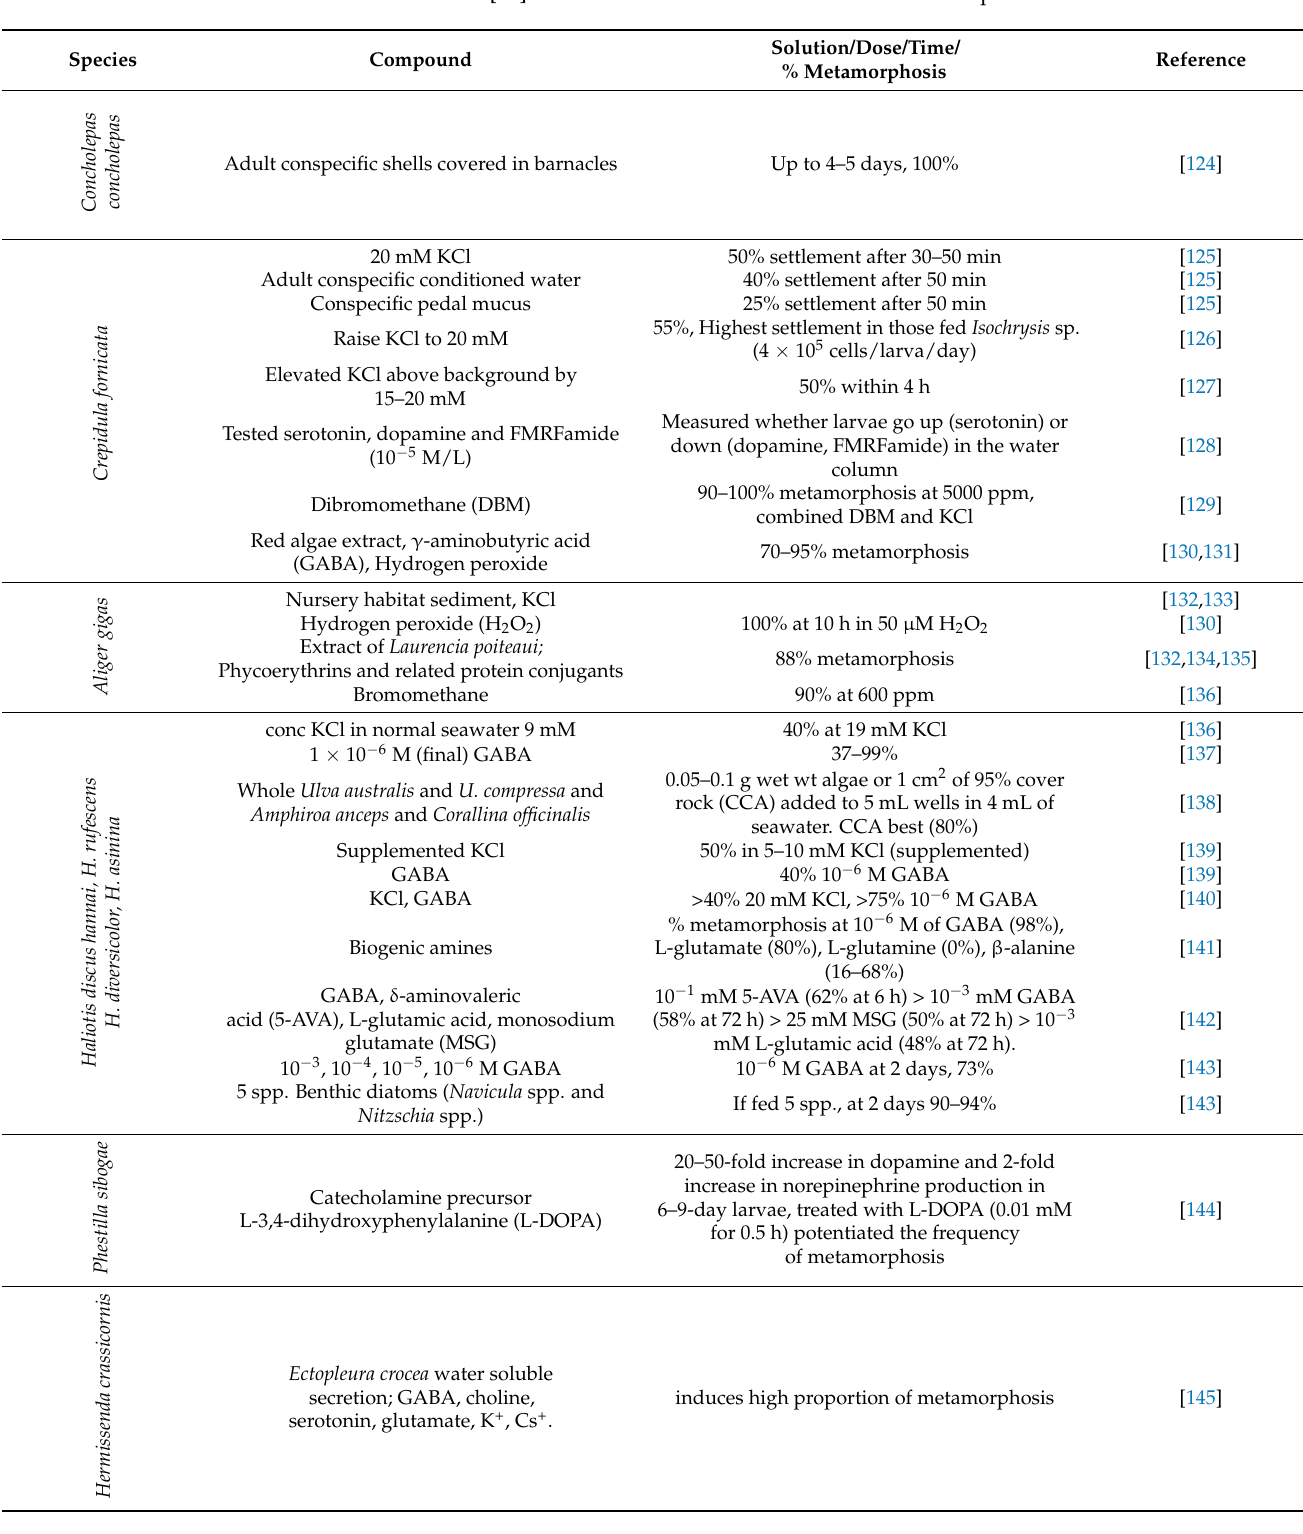
Table 3. Inducers of metamorphosis and settlement for gastropod veliger larvae (updated and modified [123]). Species for which data is limited to only settlement in presence of live prey (i.e., chemical has not been identified) have been omitted here, but are listed in [123]. Cues tested for Charonia tritonis [25] but found to be ineffective are listed as a